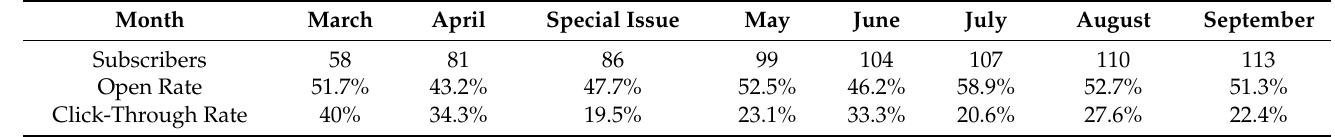
Table 3. Summary of Triton newsletter metrics by month from March 2021—September